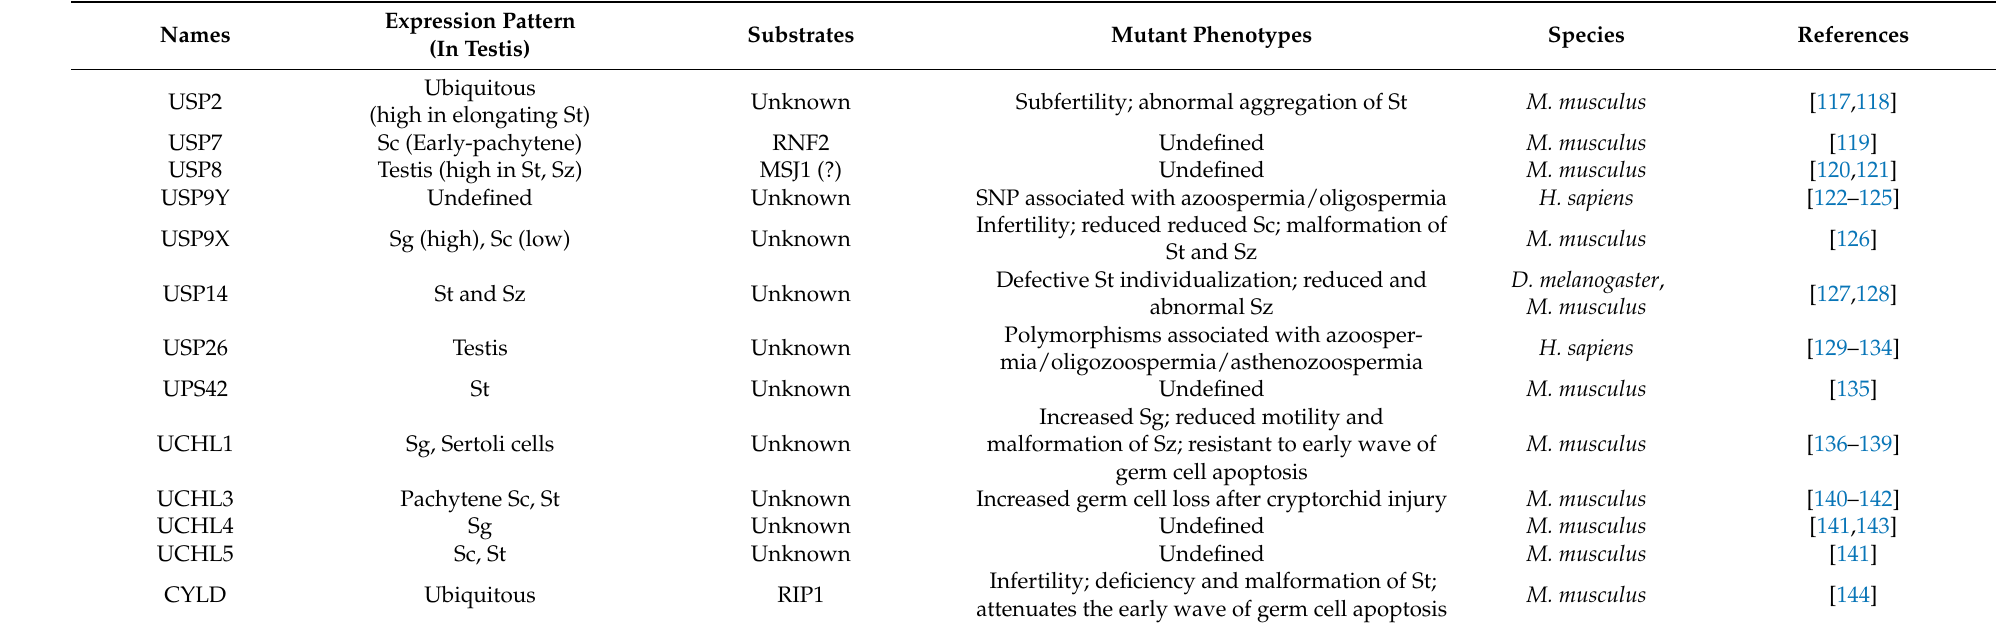
Table 2. Overview of DUBs associated with